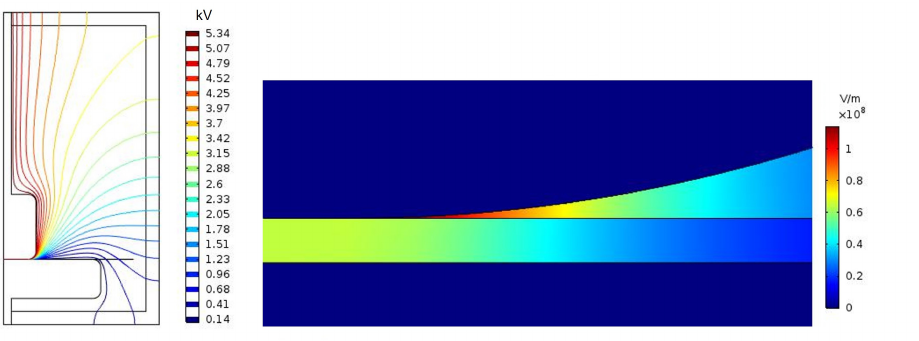
Figure 8. Finite element simulation of the test cell for the MO-impregnated paper immersed in